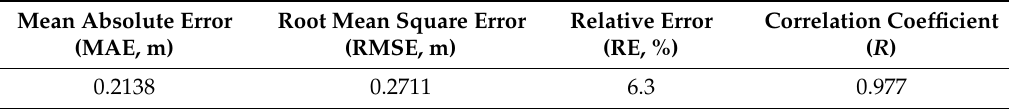
Figure 6. Comparison of sea-surface height between the model and a local XTide Station. Table 1. Error statistics for sea-surface height during the evaluation period of 29 December 2003 to 3 January